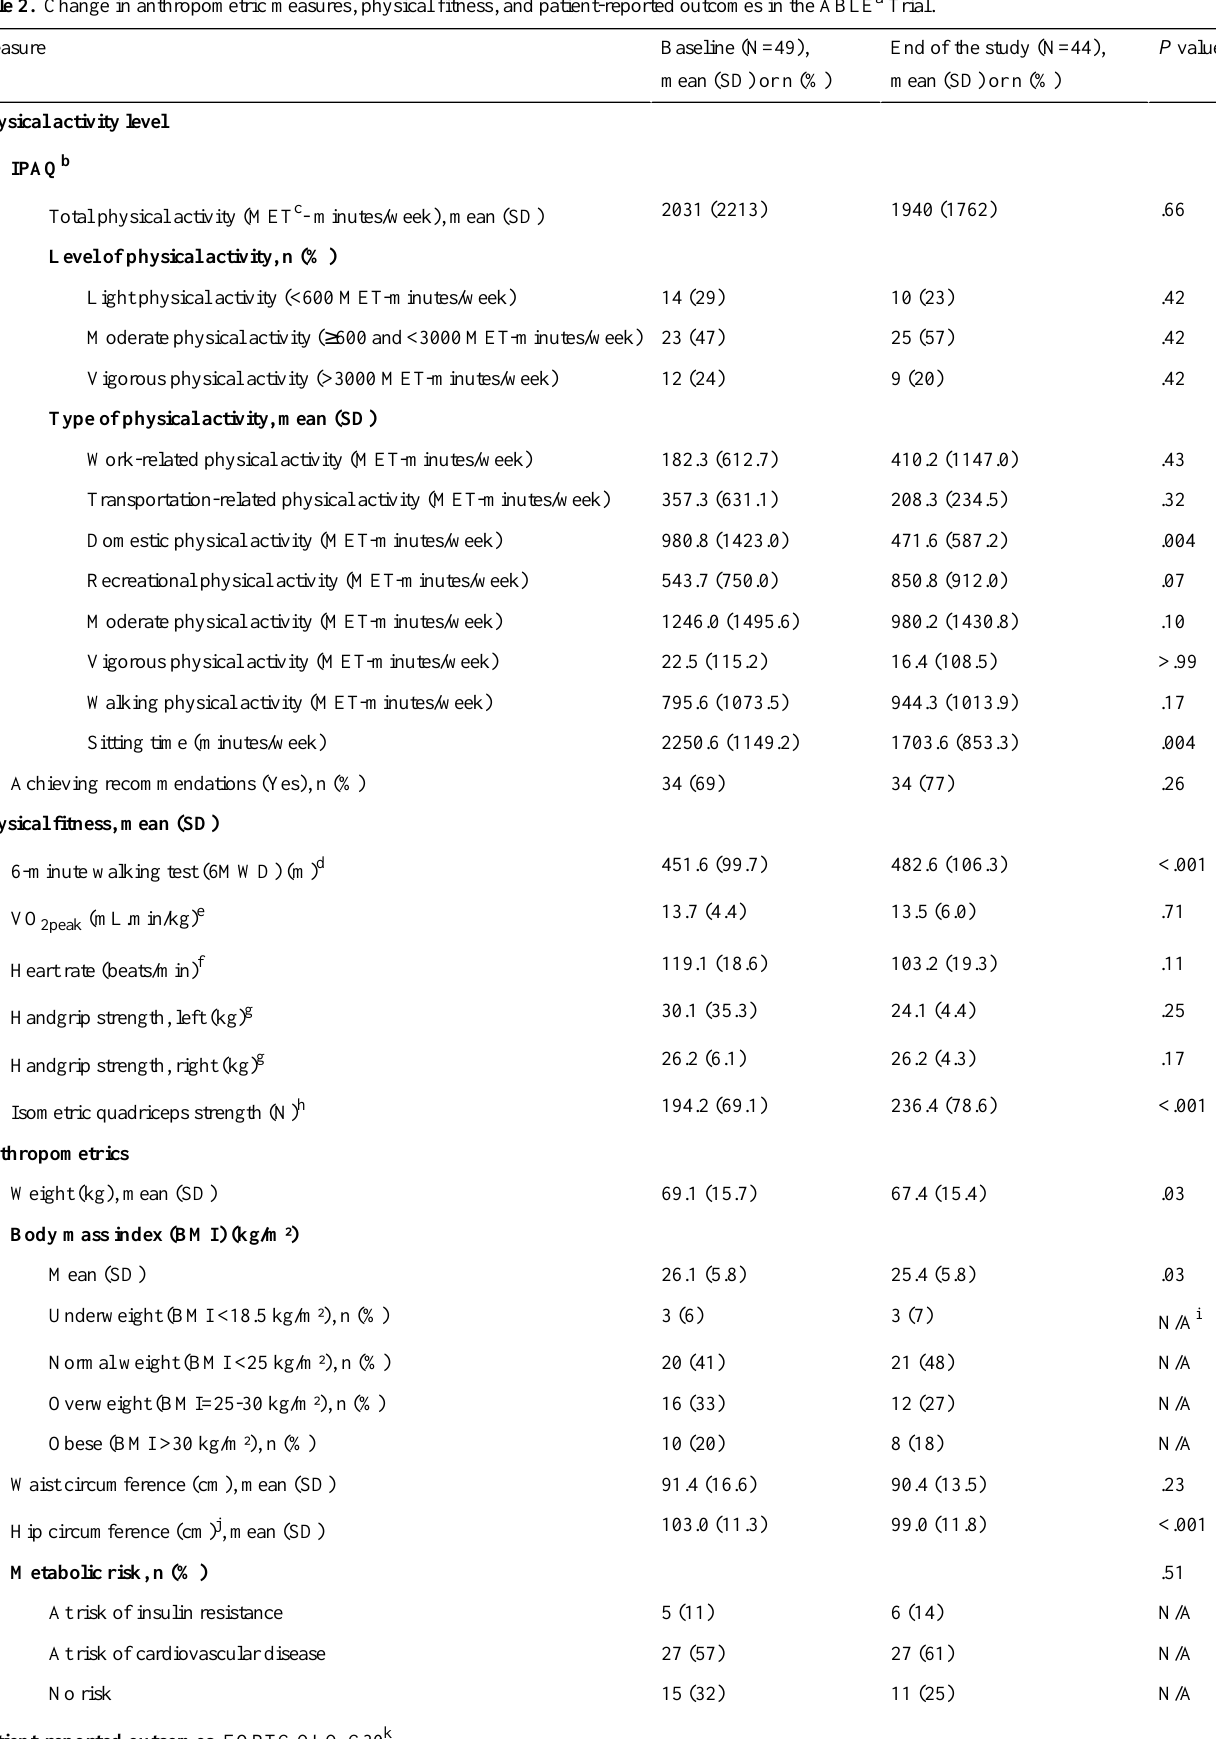
Table 2. Change in anthropometric measures, physical fitness, and patient-reported outcomes in the ABLE a Trial.